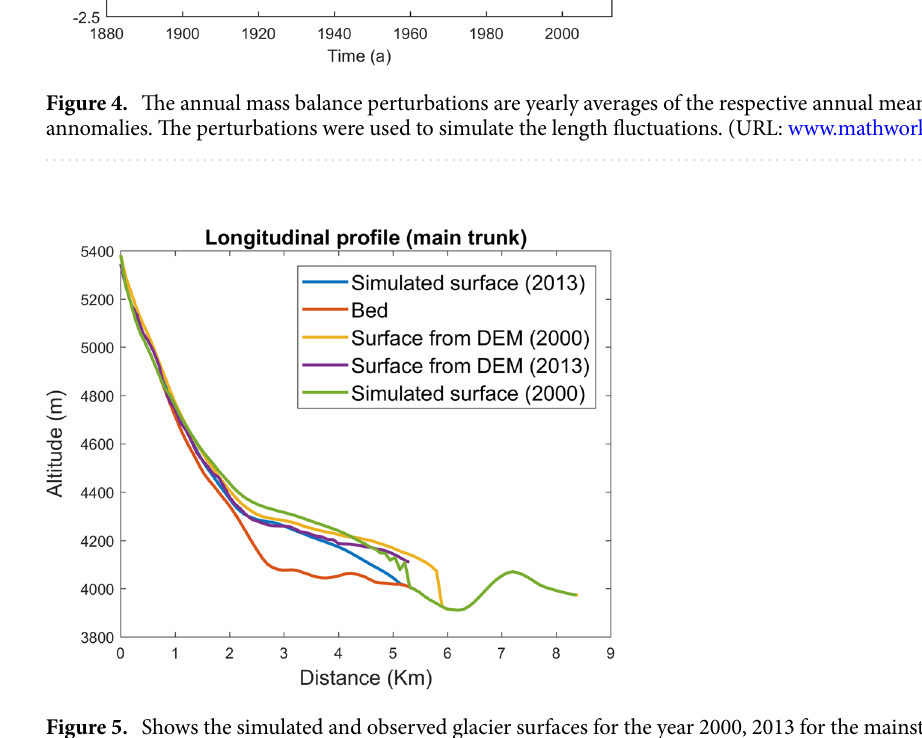
Figure 5. Shows the simulated and observed glacier surfaces for the year 2000, 2013 for the mainstream. (URL: www. mathw orks.